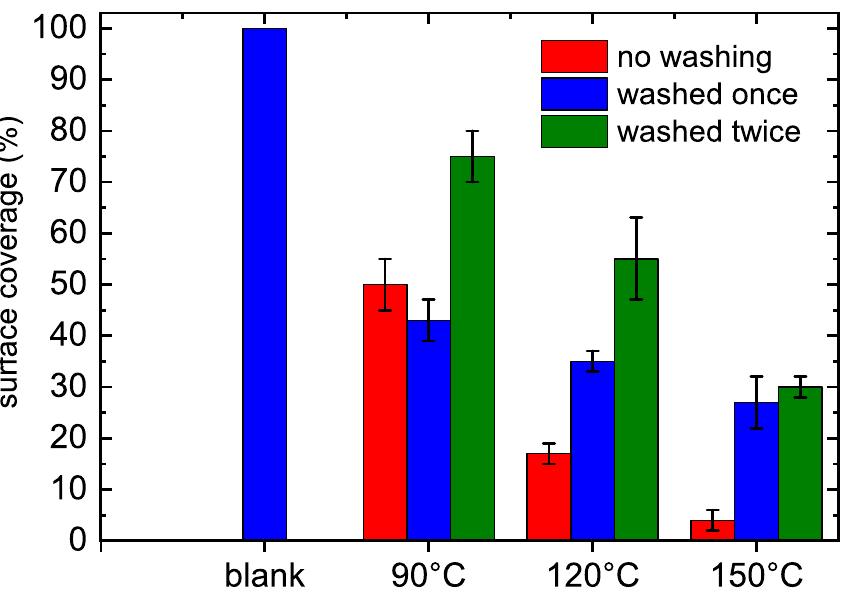
Figure 2. Bacteria S. epidermidis surface coverage area (percent) formed on POx films deposted at different substrate